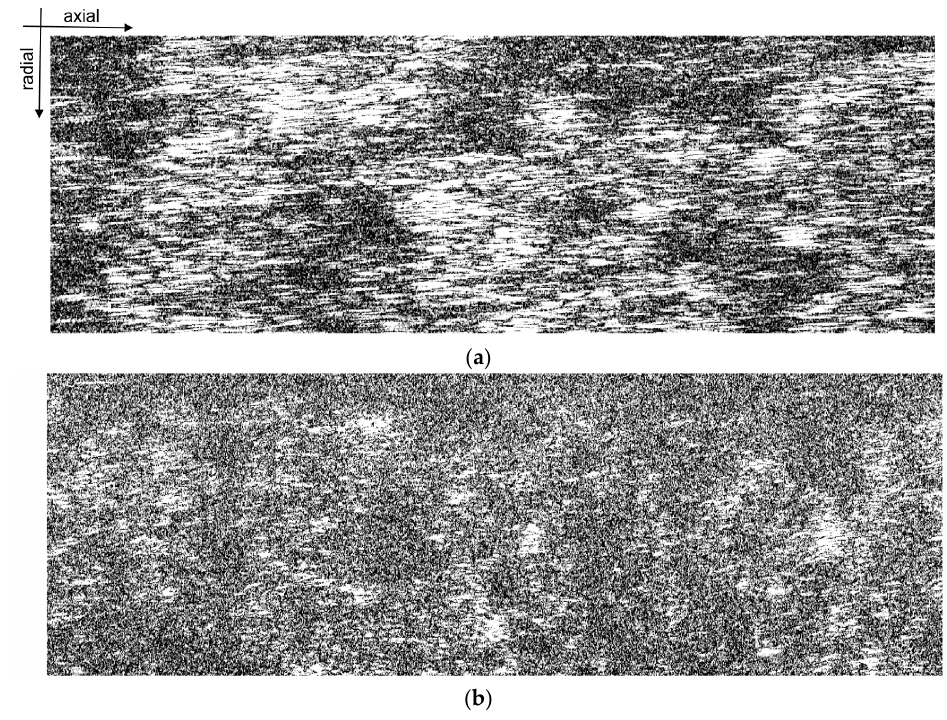
Figure 5. Intensity-corrected structural OCT images composed of successive A-scans of the suspension with the wall shear stress and scan count of ( a ) 3.8 Pa, 1000, and ( b ) 11.2 Pa, 430, respectively. Bright color indicates high and dark color low MFC consistency. Image size is 120 µm × 290 µm. The pipe wall is on the top of the image and the flow direction is from left to right. The arrows show the axial and radial directions.